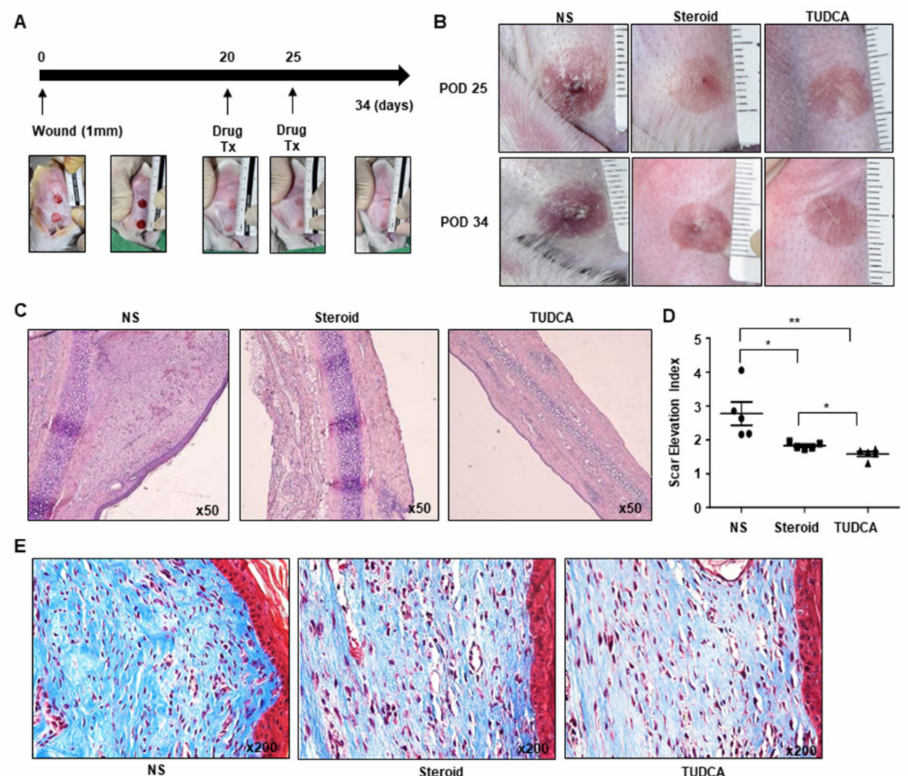
Figure 4. Rabbit ear scar model and the effect of TUDCA injection on keloid formation, compared to normal saline (NS) and steroid injection ( n = 5 for each group). ( A ) Drug injection schedule and gross images. ( B ) Gross images of the scarred regions treated with NS, steroid (10 mg/mL), and TUDCA (10 mg/mL). ( C ) Hematoxylin and eosin (H&E) staining of rabbit ear scar tissues from the NS, steroid, and TUDCA groups. ( D ) Scar elevation index (SEI) calculated based on H&E staining. ( E ) Masson’s trichrome staining of rabbit ear scar tissues from the NS, steroid, and TUDCA groups. Significance was set at p < 0.05. * p < 0.05 and ** p <